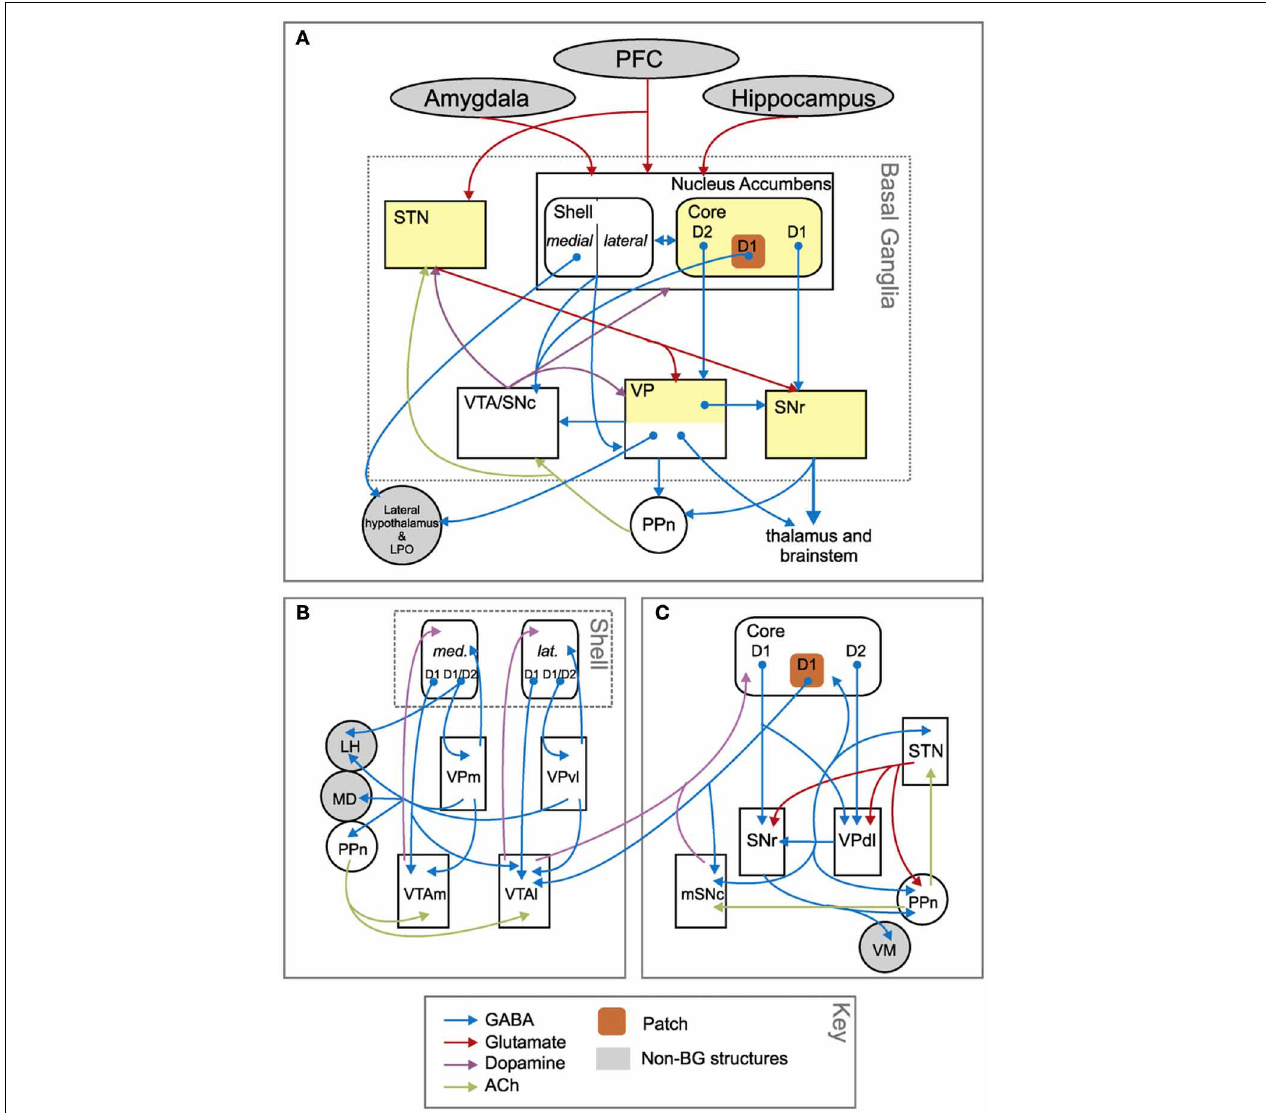
FIGURE 13 | Anatomical differences between the basal ganglia circuits involving nucleus accumbens core and shell. (A) Overall schema of the connections involving the whole nucleus accumbens. (B) Zoom on the